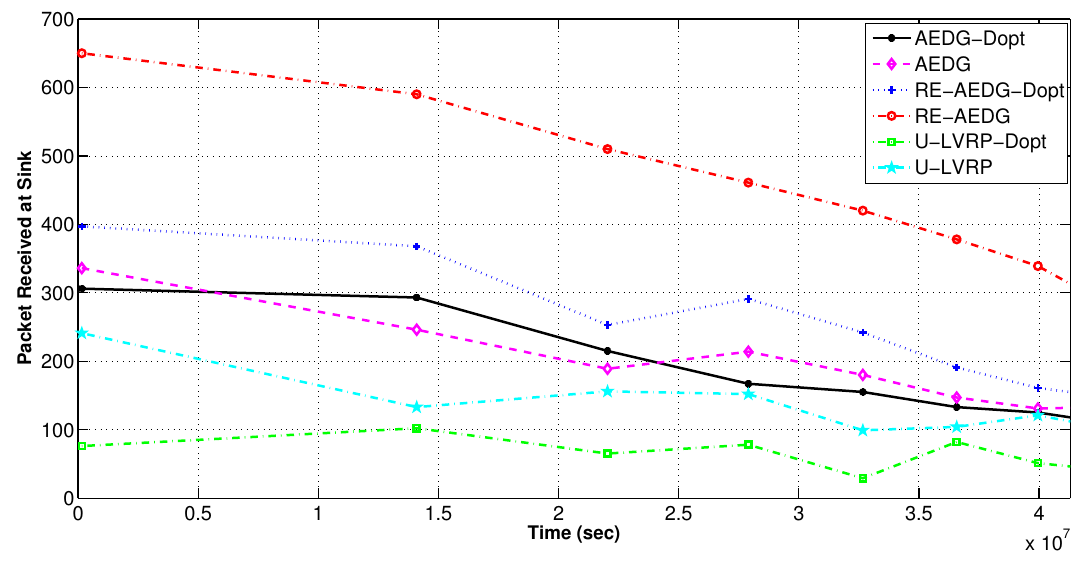
Figure 8. Packets received at sink in delay optimized and non optimized